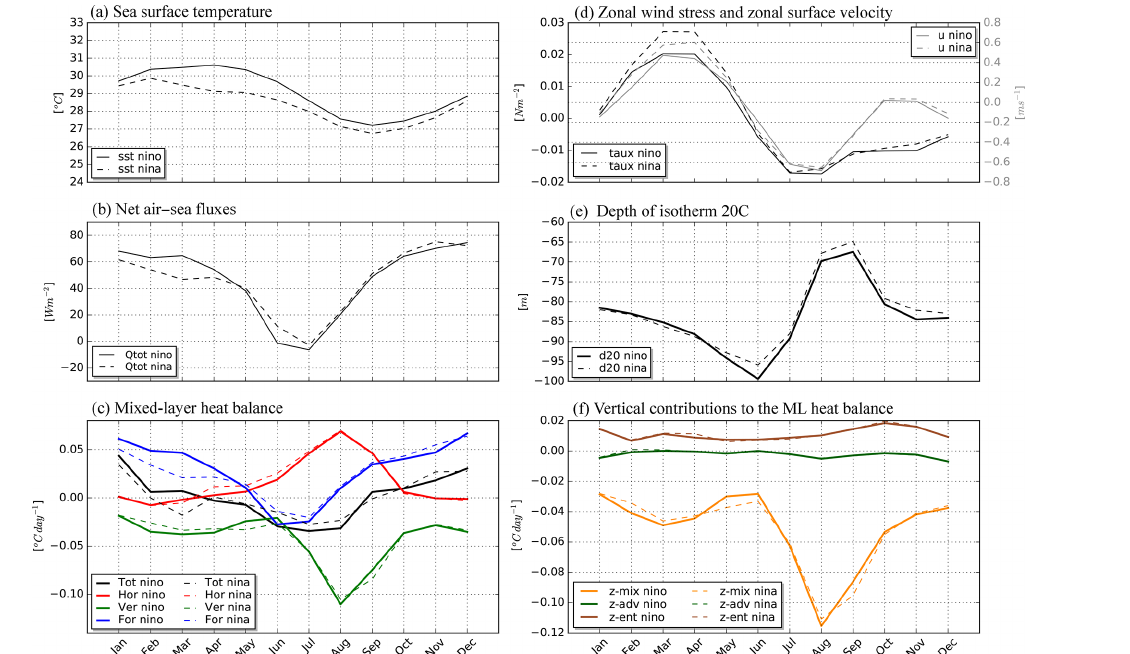
Figure 5. As Fig. 3 but using BIASED simulation. Here, Niño and Niña years were selected following the same method as in Fig. 3 but using Atl3 SSTs from BIASED, so they do not necessarily coincide with observed Niño and Niña